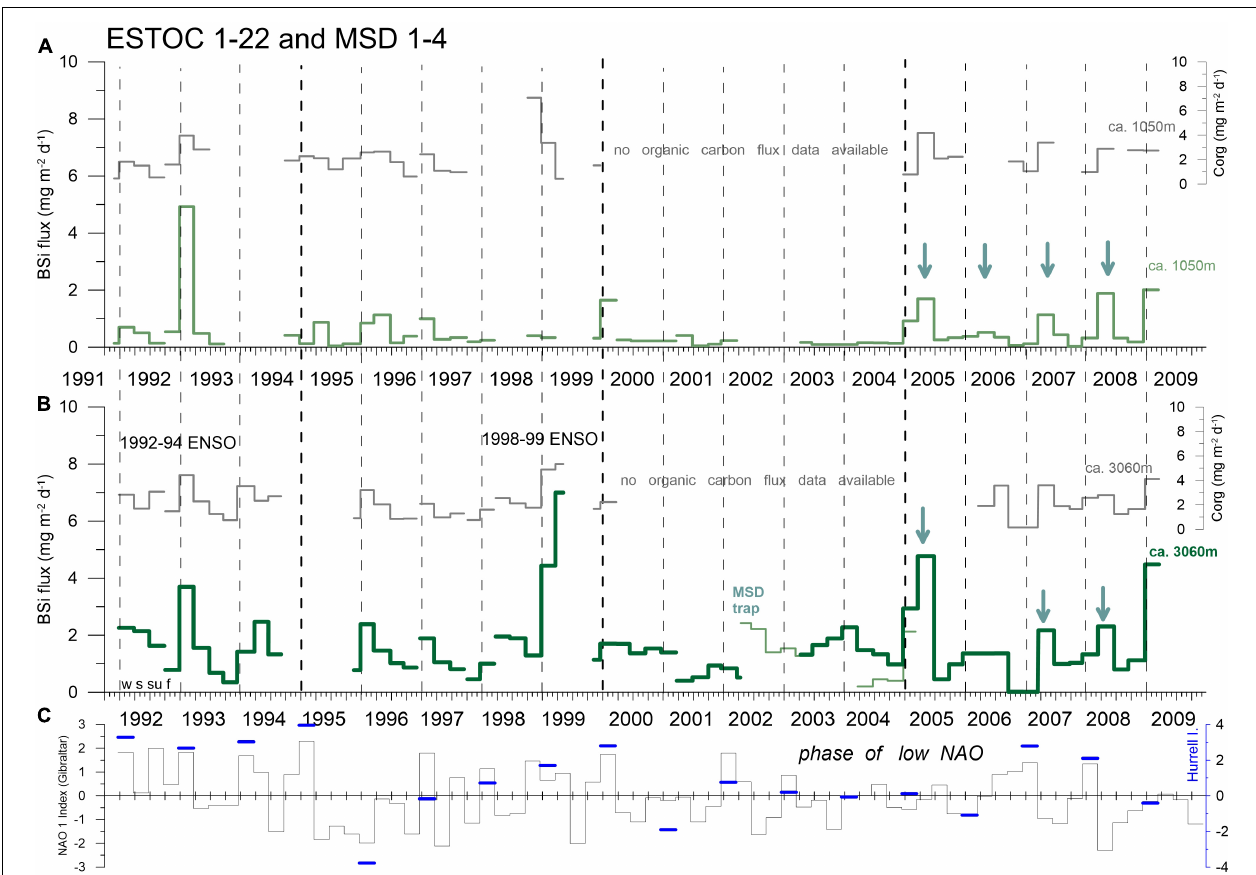
FIGURE 7 | Seasonal fluxes of BSi (mg m − 2 d − 1 ) at ESTOC and MSD in the upper ( A , ca. 1050 m) and lower water column ( B , ca. 3060 m) together with two NAO indices (C) . Available organic carbon fluxes are shown as well. Major spring peaks after 2005 are marked with green arrows. Vertical hatched lines indicate years (with the four seasons winter = w, spring = s, summer = su, fall = f; starting on Jan. 1), thick hatched lines indicate a 5-year